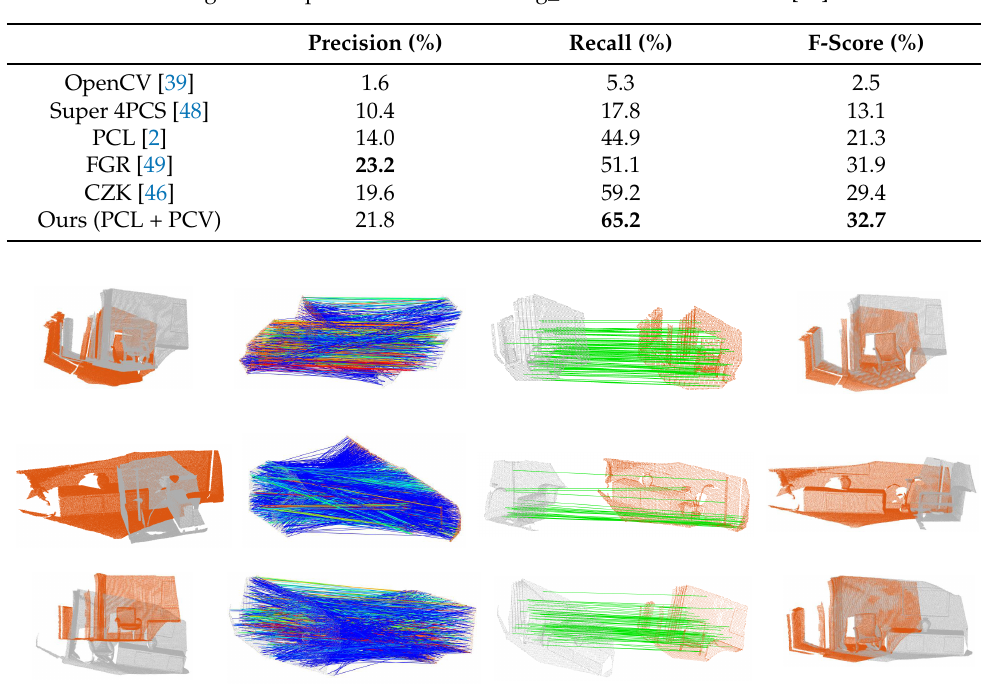
Figure 8. Sample registration results from the Aug_ICL-NUIM benchmark based on PCL+PCV. From left to right: initial point clouds, scoring results by PCV, top-scored correspondences selected by PCV, point clouds after